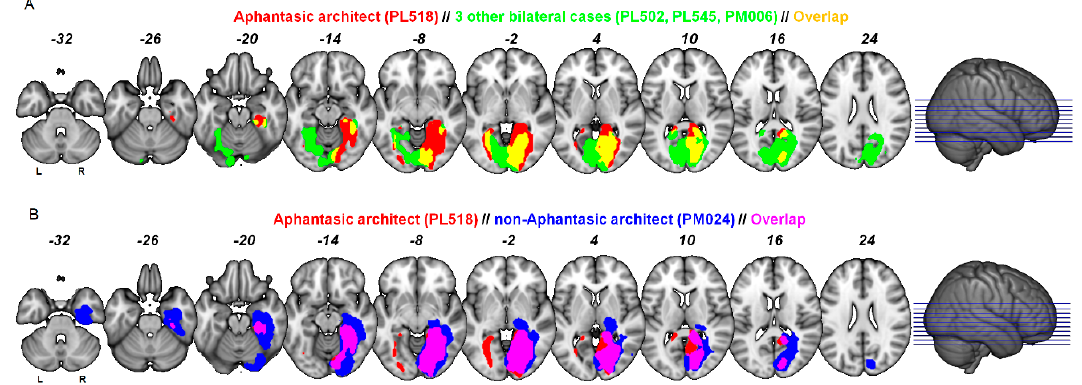
Figure 3. ( A ) shows lesion overlap between PL518 and the other bilateral patients. ( B ) shows lesion overlap between PL518 and PM024. Left hemisphere depicted on the left. The lesions are in MNI space overlaid on the MNI152 template. See Figure S2 for individual comparisons of PL518 and the bilateral patients. Table 2. Comparison of regions of interest within the occipital and temporal lobes a ff ected in PL518 compared to other patients. The fusiform gyrus (FG) was segmented into four regions (FG1-4: corresponding to posterior medial, posterior lateral, anterior medial and anterior lateral, respectively) according to Lorenz and colleagues [57]. The occipital pole and the lingual gyrus were defined using a conventional atlas [58], and the parahippocampal region was identified using the images from Bouyeure and colleagues [59]. An x indicates that at least 10% of the corresponding region of interest was a ff ected by a patient’s stroke. Laterality Bilateral Bilateral Bilateral Bilateral Right Patient PL518 PL502 PM024 Occipital Pole x x Right FG 1 x x FG 2 x Left hemisphere x x Occipital Pole x x x Right hemisphere